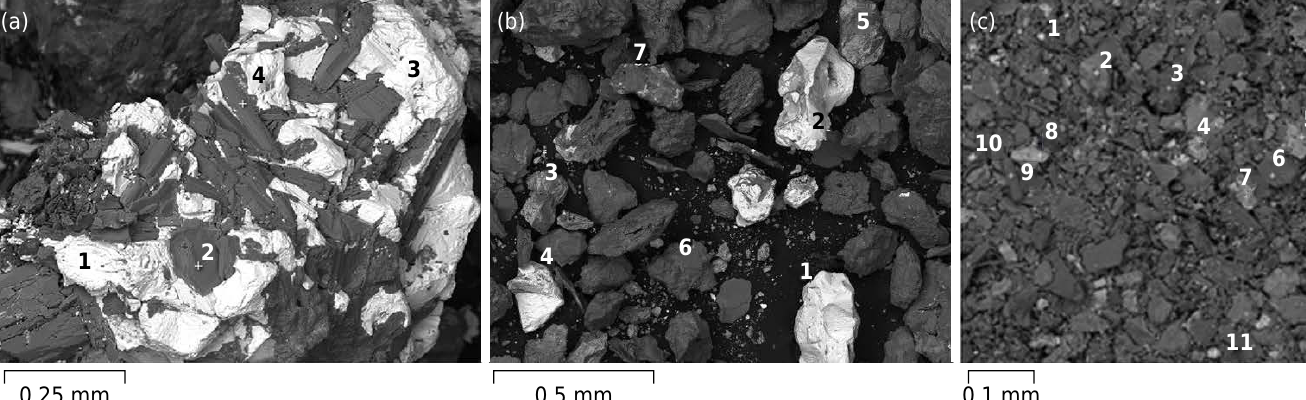
Figure 7. Scanning Electron Microscopy images of sand (A and B) and silt (C) particles from sample 23.